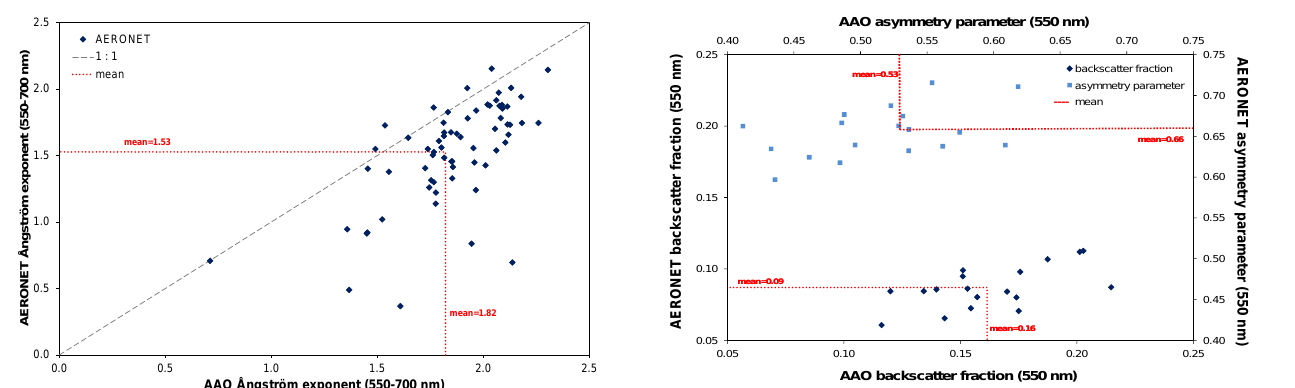
Fig. 3. Comparison of AAO aircraft calculated ˚Angstr¨om exponent with AERONET ˚Angstr¨om exponent (adjusted to 550–700nm).